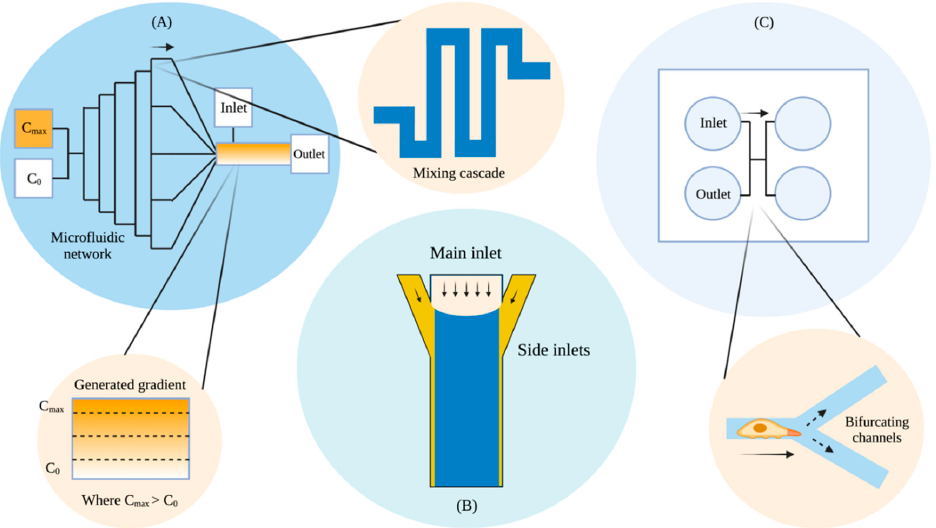
Figure 3. Simplistic adapted diagram highlighting: ( A ) Song’s generation of a linear concentration gradient through a pyramidal microfluidic network of mixing cascades for the study of D. discoideum chemotaxis; ( B ) Meier’s tuneable microfluidic function generator through controlled flow for the study of directed cell migration; and ( C ) a top-down view of Belotti’s microfluidic chip with a decoupling of the barotactic and chemotactic channels for the study of D. discoideum’s directional decision making. Arrows indicate the direction of fluid flow and cell movement, where applicable. Created with BioRender.com (https://app.biorender.com/). Last accessed on 19 September 2022.